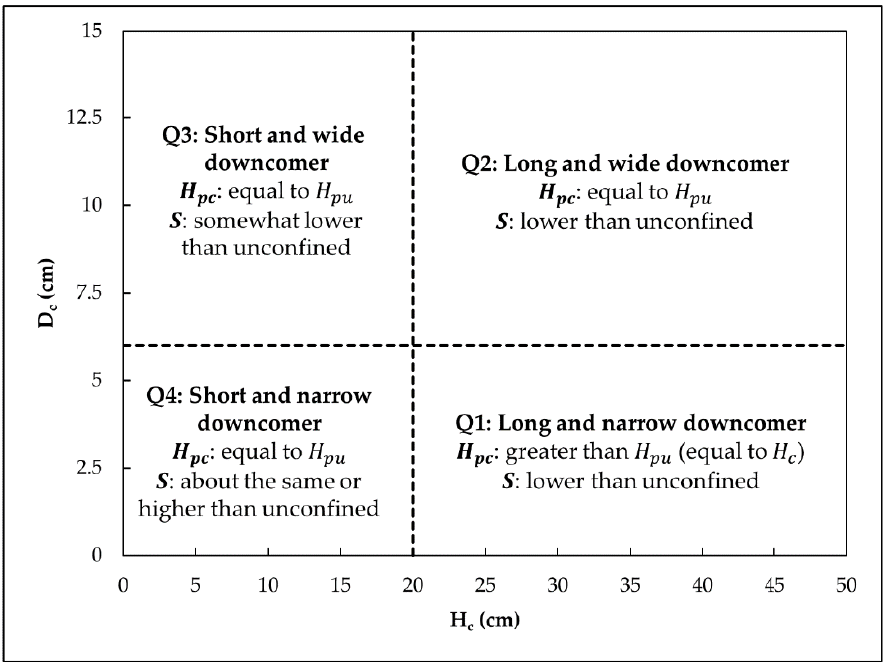
Figure 8. Bubble penetration depth (H pc ) and dilution (S) of confined plunging jets as functions of downcomer dimensions (H c and D c ). (The delineation between small and large D c is made at D c /d 0 = 6. Short and long downcomers are delineated by comparing them to the bubble penetration depth of an unconfined jet (H pu ) which is equal to 20 cm.)